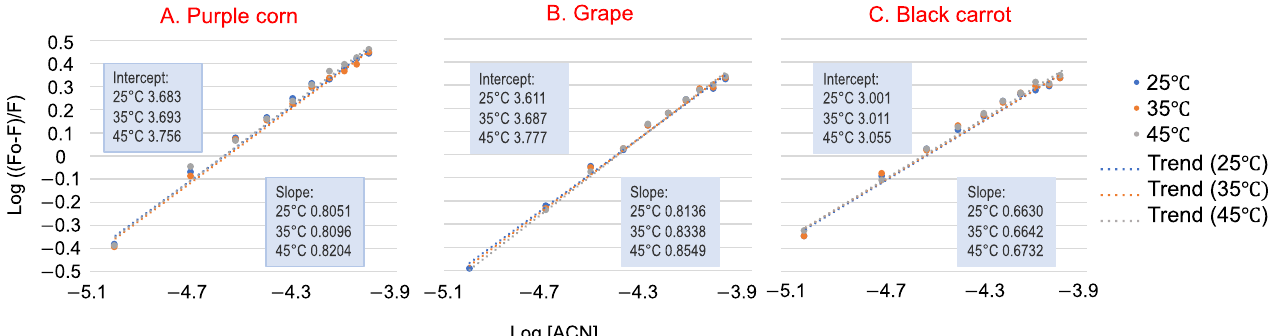
Figure 3. The double logarithm regression plots of log [(F 0 − F)/F] versus log [ACN] (purple corn ( A ), grape ( B ) and black carrot ( C )) of whey protein at 25 °C, 35 °C and 45 °C (used for K s calculation). Data presented are means of three replications. Standard deviations for all data points are less than 0.02.